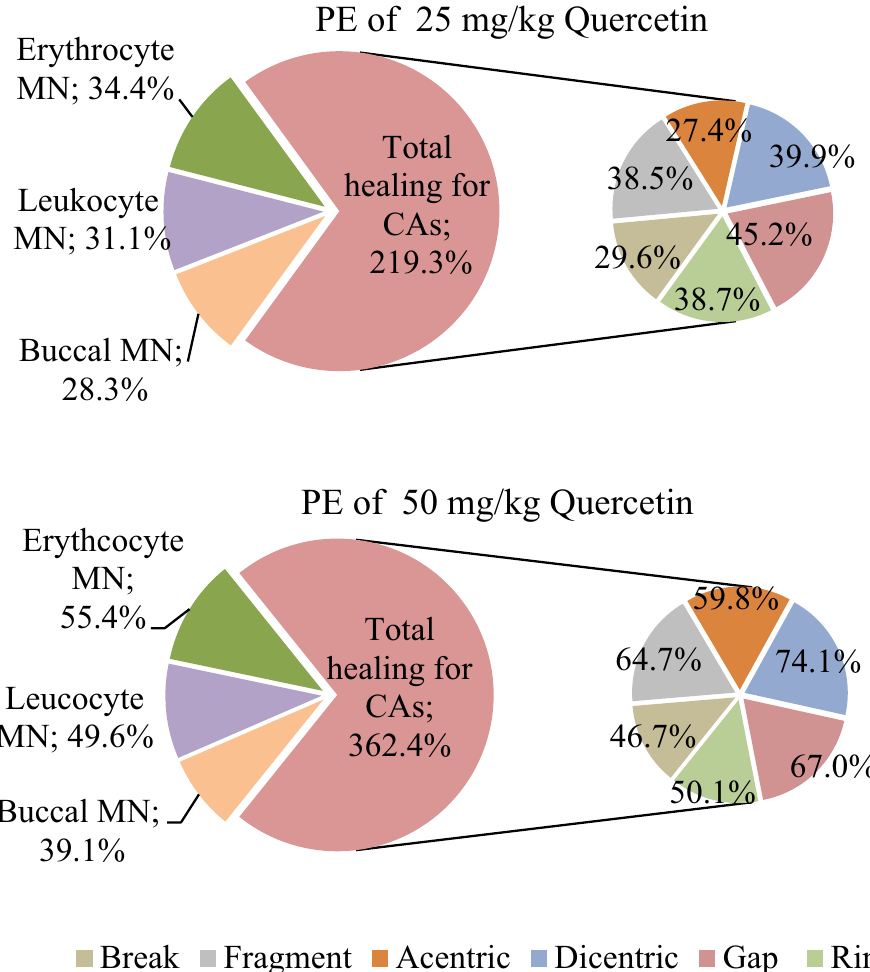
Figure 7. Protective effects (PE) of 25 mg/kg b.w and 50 mg/kg b.w quercetin applications against MN and CAs